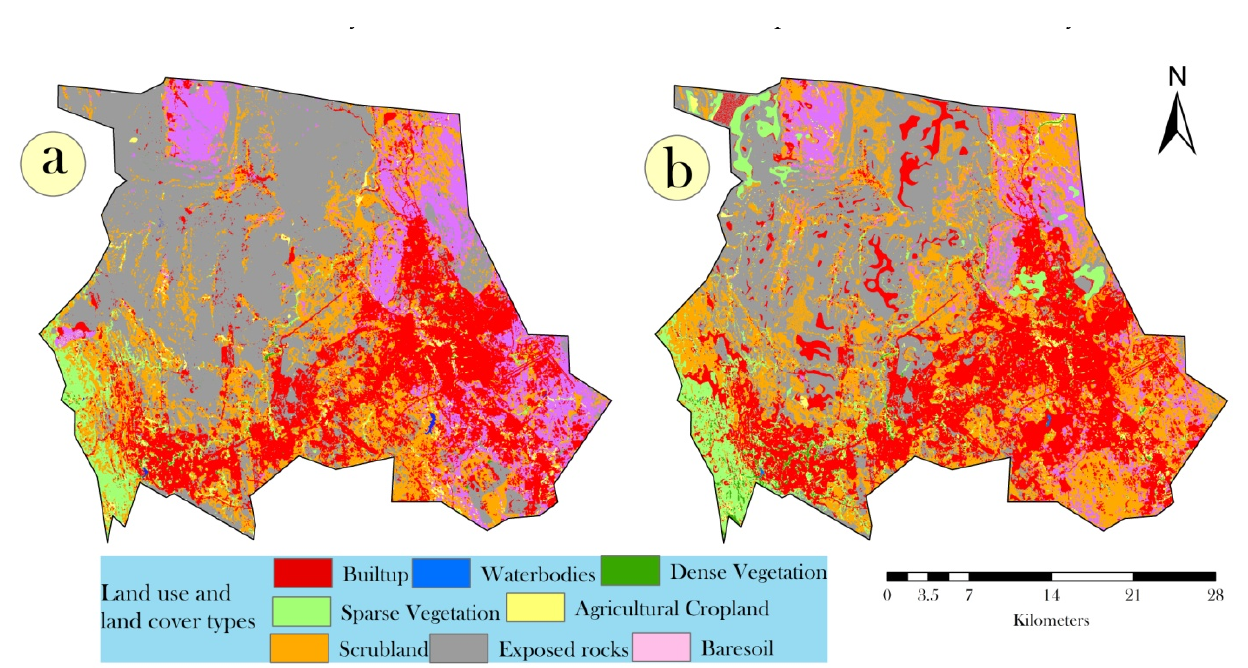
Figure 3. LULC simulation and prediction for ( a ) 2018 and ( b ) 2028.